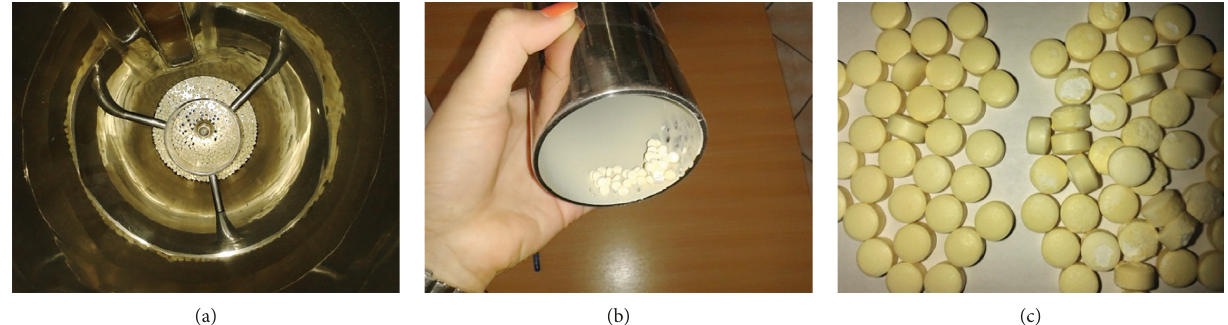
Figure 3: Photographs of the coating chamber filled with tablets, tablets stuck on Wurster tube, and coated